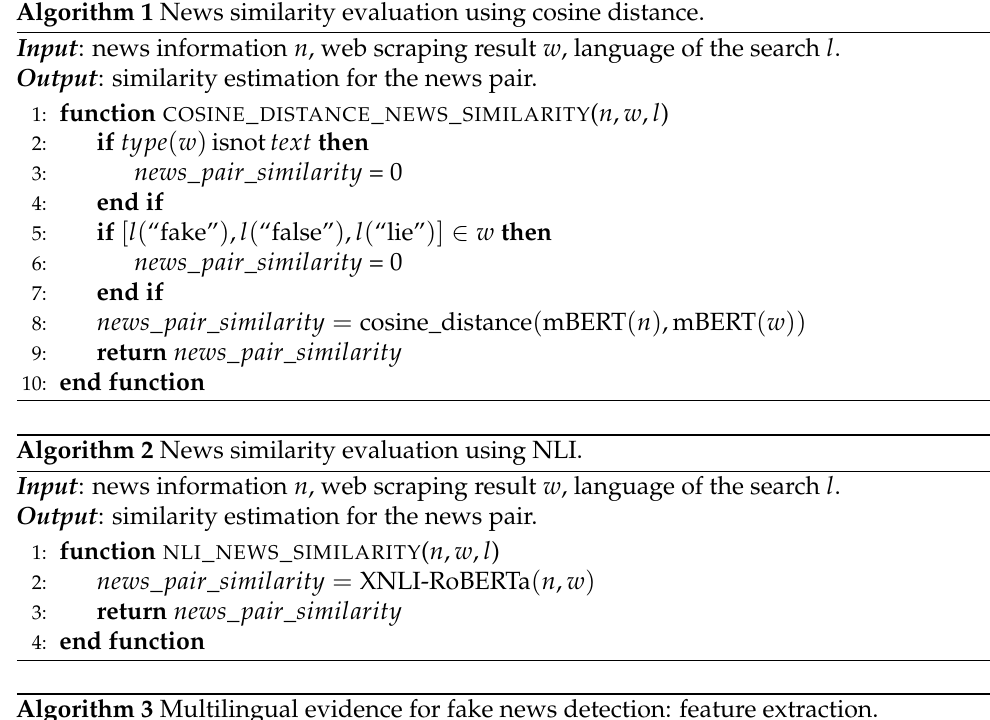
Algorithm 3 Multilingual evidence for fake news detection: feature